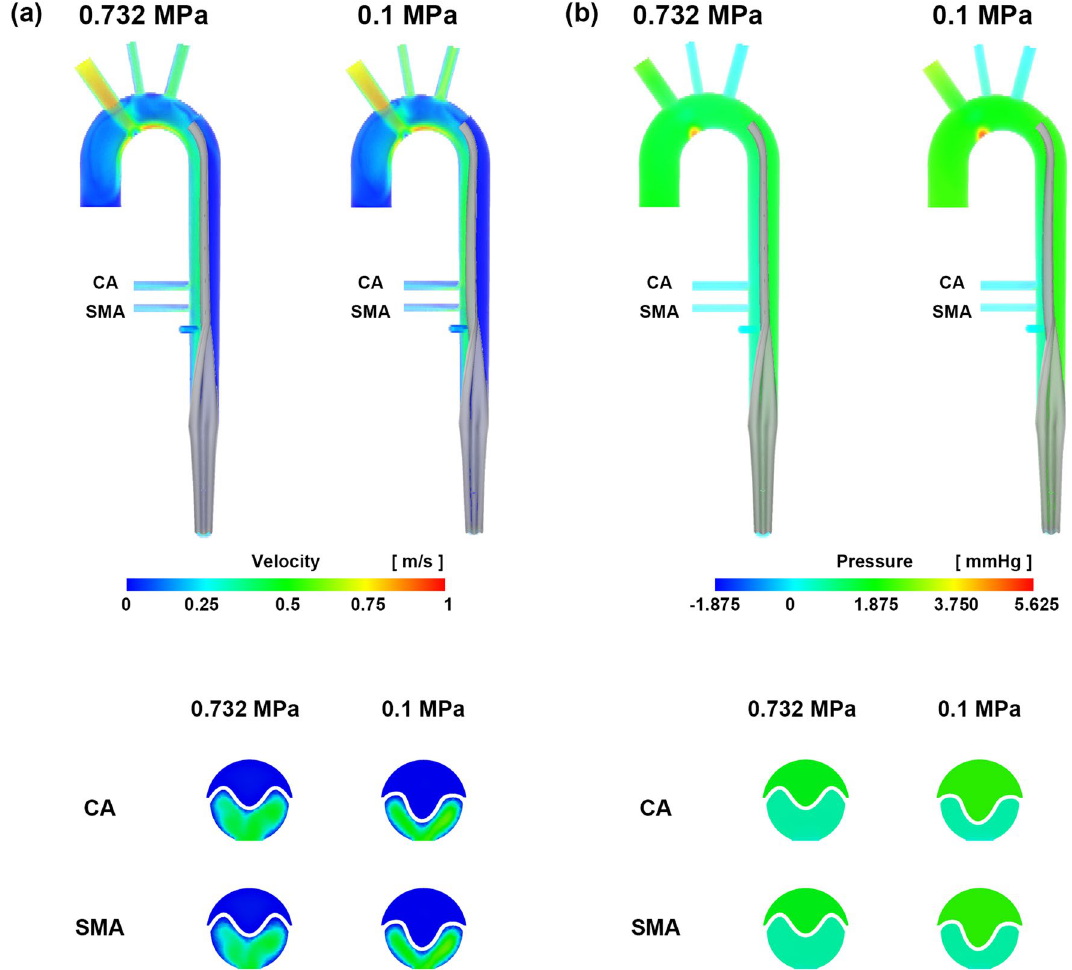
Figure 8. Velocity and pressure contour comparison according to stiffness at an AC flow rate of 4 L/min. ( a ) Velocity and ( b ) pressure. These images were made with Ensight (v.2021 R1, https:// www. ansys. com) using FSI